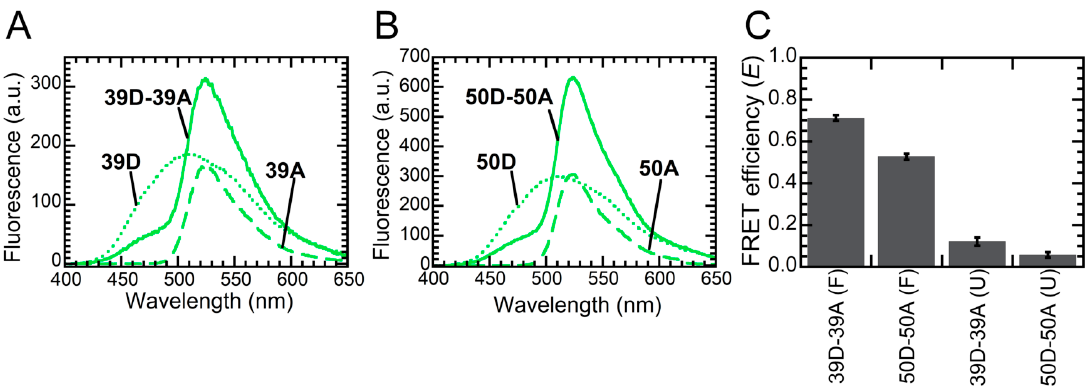
Figure 3. FRET measurements for NTD dimers labeled with 1,5-IAEDANS as a donor (D) and 6-IAF as an acceptor (A). ( A , B ) Fluorescence spectra of NTD labeled at position 39 ( A ) or 50 ( B ) with donor only (dotted line), acceptor only (dashed line) or a 1:1 molar ratio of donor and acceptor (continuous line) in the absence of urea. ( C ) FRET efficiency for NTD dimers labeled at position 39 (bars 1 and 3) or 50 (bars 2 and 4), in the absence (labeled as F) or presence (labeled as U) of 6.0 M urea. Each FRET (cid:1831) value is the mean of the FRET (cid:1831) values determined with the donor fluorescence (450-480 nm) and acceptor fluorescence (520-530 nm).